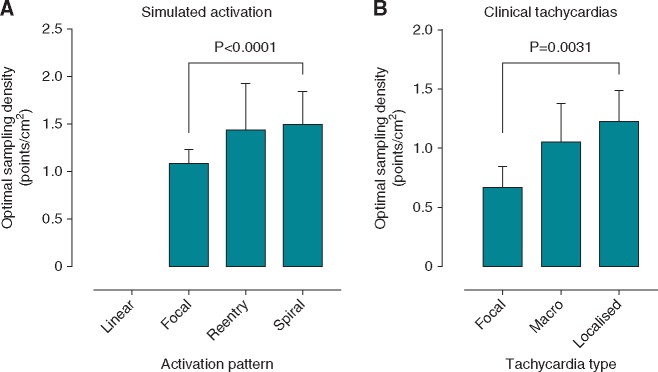
Optimal LAT sampling densities. Calculated optimal LAT sampling densities are shown for simulated activation patterns (A) and in vivo LA activation patterns (B). FO, focal origin; MA, macro re-entry; MI, micro (localised) re-entry.